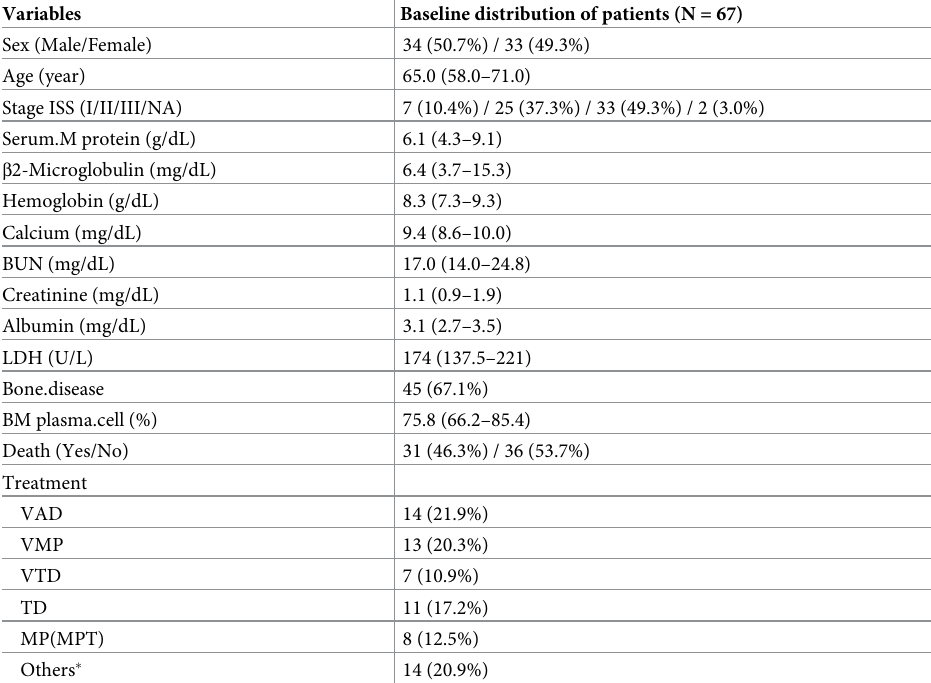
Table 1. Demographic and clinical characteristics of the study